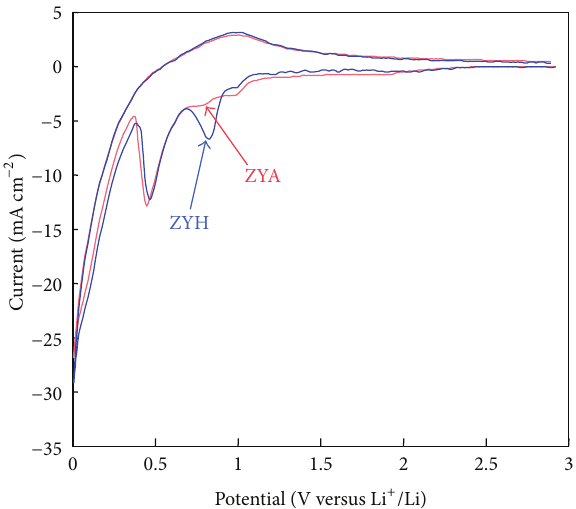
Figure 5: Cyclic voltammograms in the first cycle of ZYA and ZYH samples in 1 M LiClO 4 /EC + DEC. Sweep rate: 0.5 mVs −1